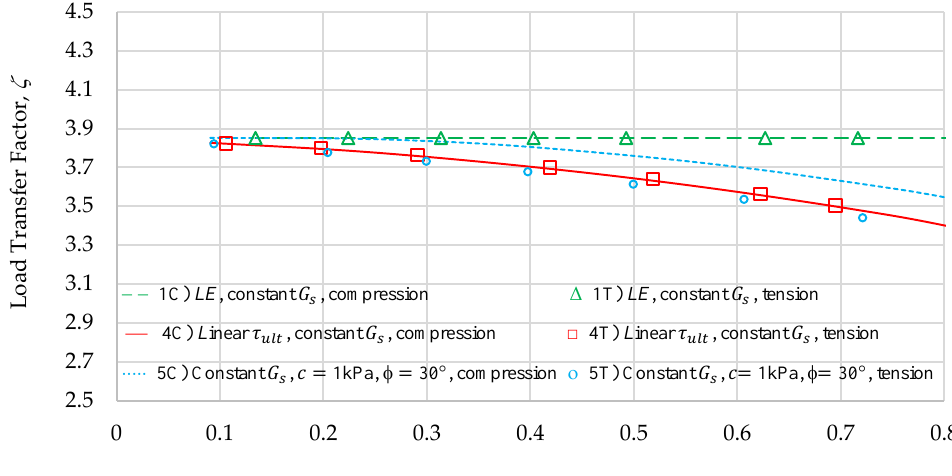
Figure 9. Load-transfer factor versus stress ratio at the mid-depth level of the pile as head load increases in Models 1, 4, 5.